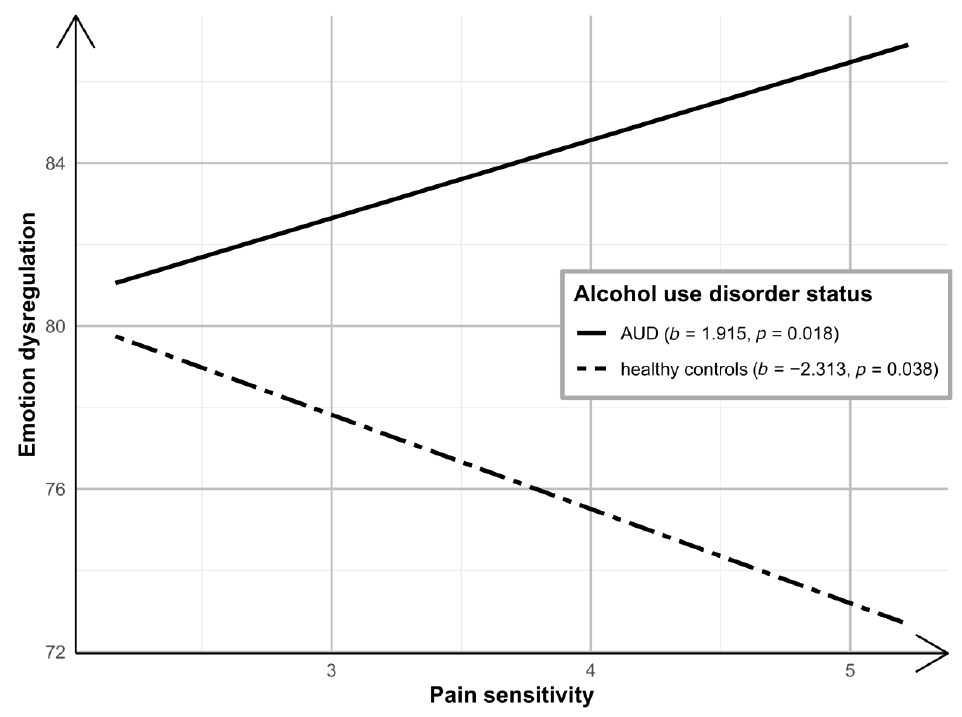
Figure 3. Pain sensitivity effect on emotional dysregulation by AUD status.